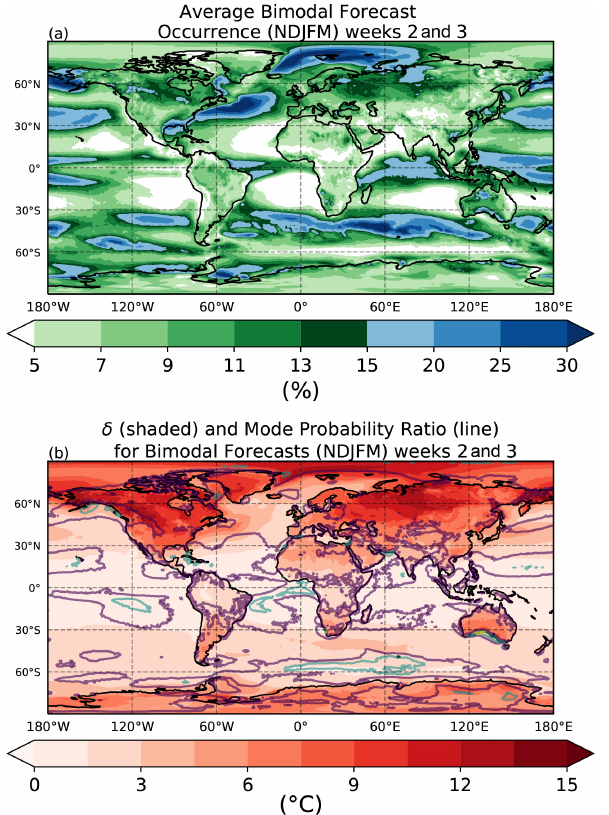
Figure 8. (a) The average occurrence of forecasts that are con- sidered bimodal for all Northern Hemisphere extended summer months (May, June, July, August, September) in the ECMWF dataset. (b) The accompanying average δ between the two modes (shaded) and the relative probability of the absolute maximum com- pared to the relative minimum for forecasts that are bimodal (con- tour). Purple, blue, and yellow contours represent 2 times, 3 times, and 4 times as likely,